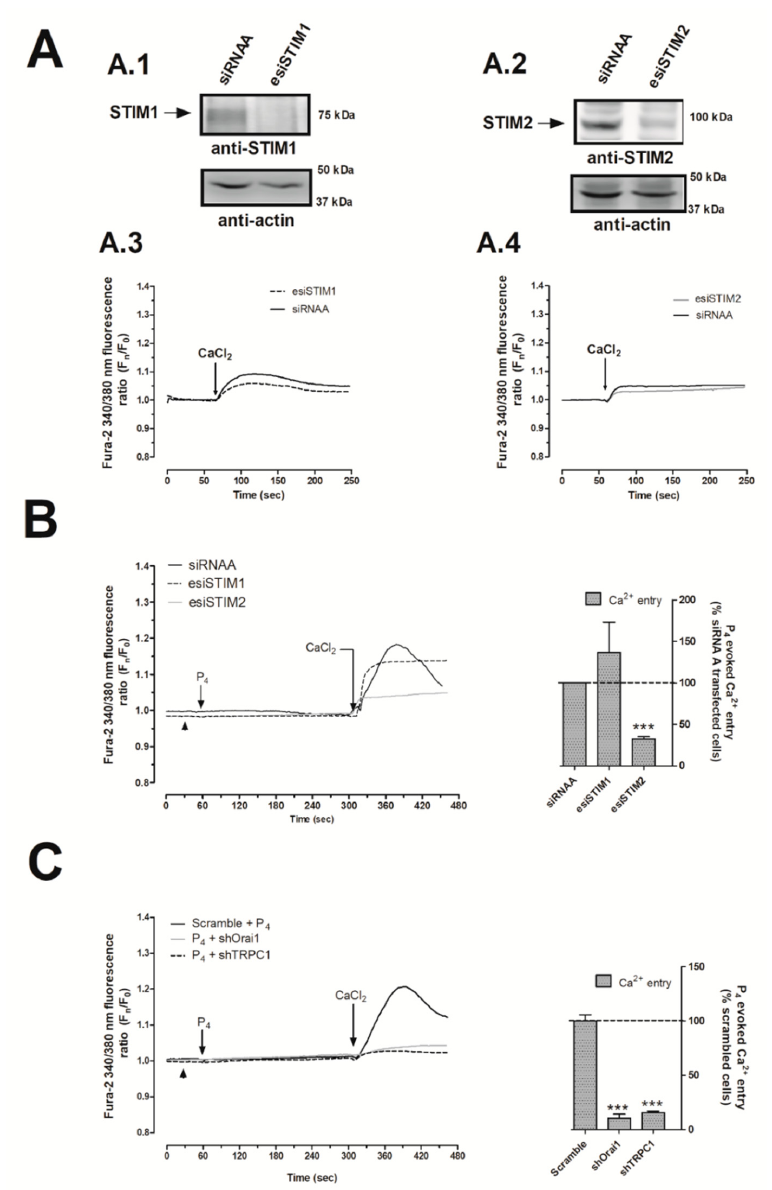
Figure 4. Progesterone (P 4 ) activated the stromal interaction molecule 2 (STIM2) that drives calcium (Ca 2+ ) entry through Calcium release-activated calcium channel protein 1 (Orai1) and transient receptor potential channel 1 (TRPC1). MDA-MB-231 cells were transfected with 2 μ g/mL of either endoribonuclease-generated siRNA against STIM1 (esiSTIM1) ( A.1 , A.3 (dotted trace) and B ) or esiSTIM2 ( A.2 , A.4 (grey trace) and B ) or with a non-specific siRNA ( A.1 – A.4 (black trace) and B ) for 48 h. Alternatively, we used 2 μ g/mL of small hairpin RNA against Orai1 (shOrai1) ( C , grey solid line) or shTRPC1 ( c ; black dotted line) or empty vector ( C , scrambled cells, black trace) for 48 h. Upon confirmation of the efficiency of the protein silencing protocols by Western blotting using the specific antibodies as indicated ( A.1 , A.2 ), Ca 2+ experiments were performed according to the procedures described in Materials and Methods. Briefly, fura-2-loaded MDA-MB-231 cells were maintained in a Ca 2+ -rich medium (containing 1 mM of CaCl 2 , A.3 , A.4 ) and were kept untreated; while other cells were maintained in a Ca 2+ -free HBS medium (75 μ M of ethylene glycol-bis( β -aminoethyl ether)- N , N , N ′ , N ′ -tetraacetic acid (EGTA) was added, arrowheads ( B , C )) and were stimulated with 1